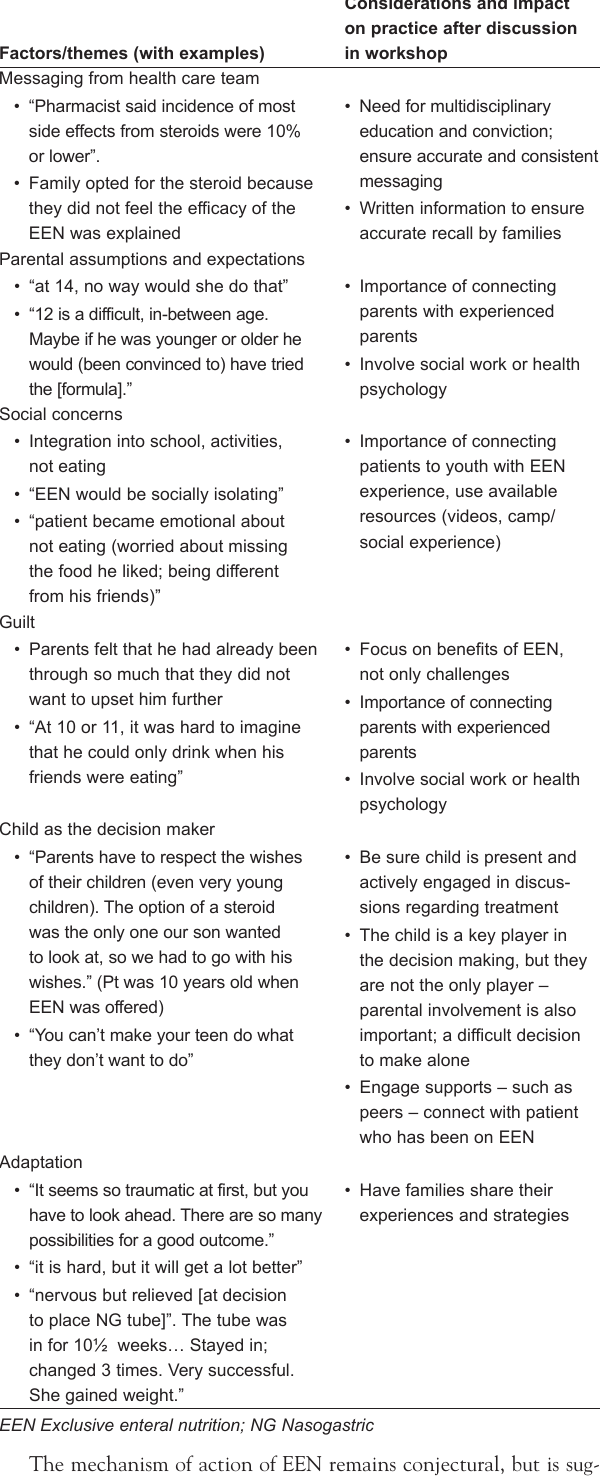
Summarized barriers and enablers from group exercise